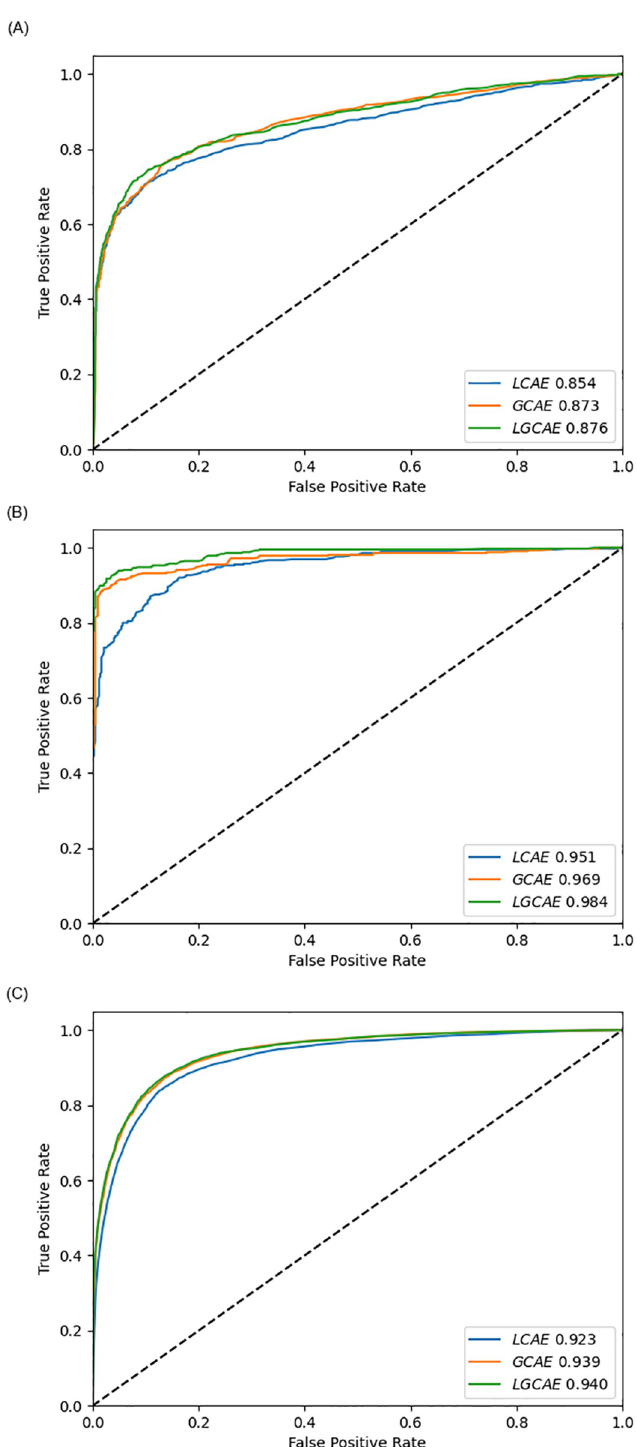
Fig 7. AU-ROC performance figures produced by proposed LGCA-VHPPI on 3 benchmark viral-host PPIs datasets. (a) Barman et al dataset. (b) DeNovo et al dataset. (c) Yang et al dataset.